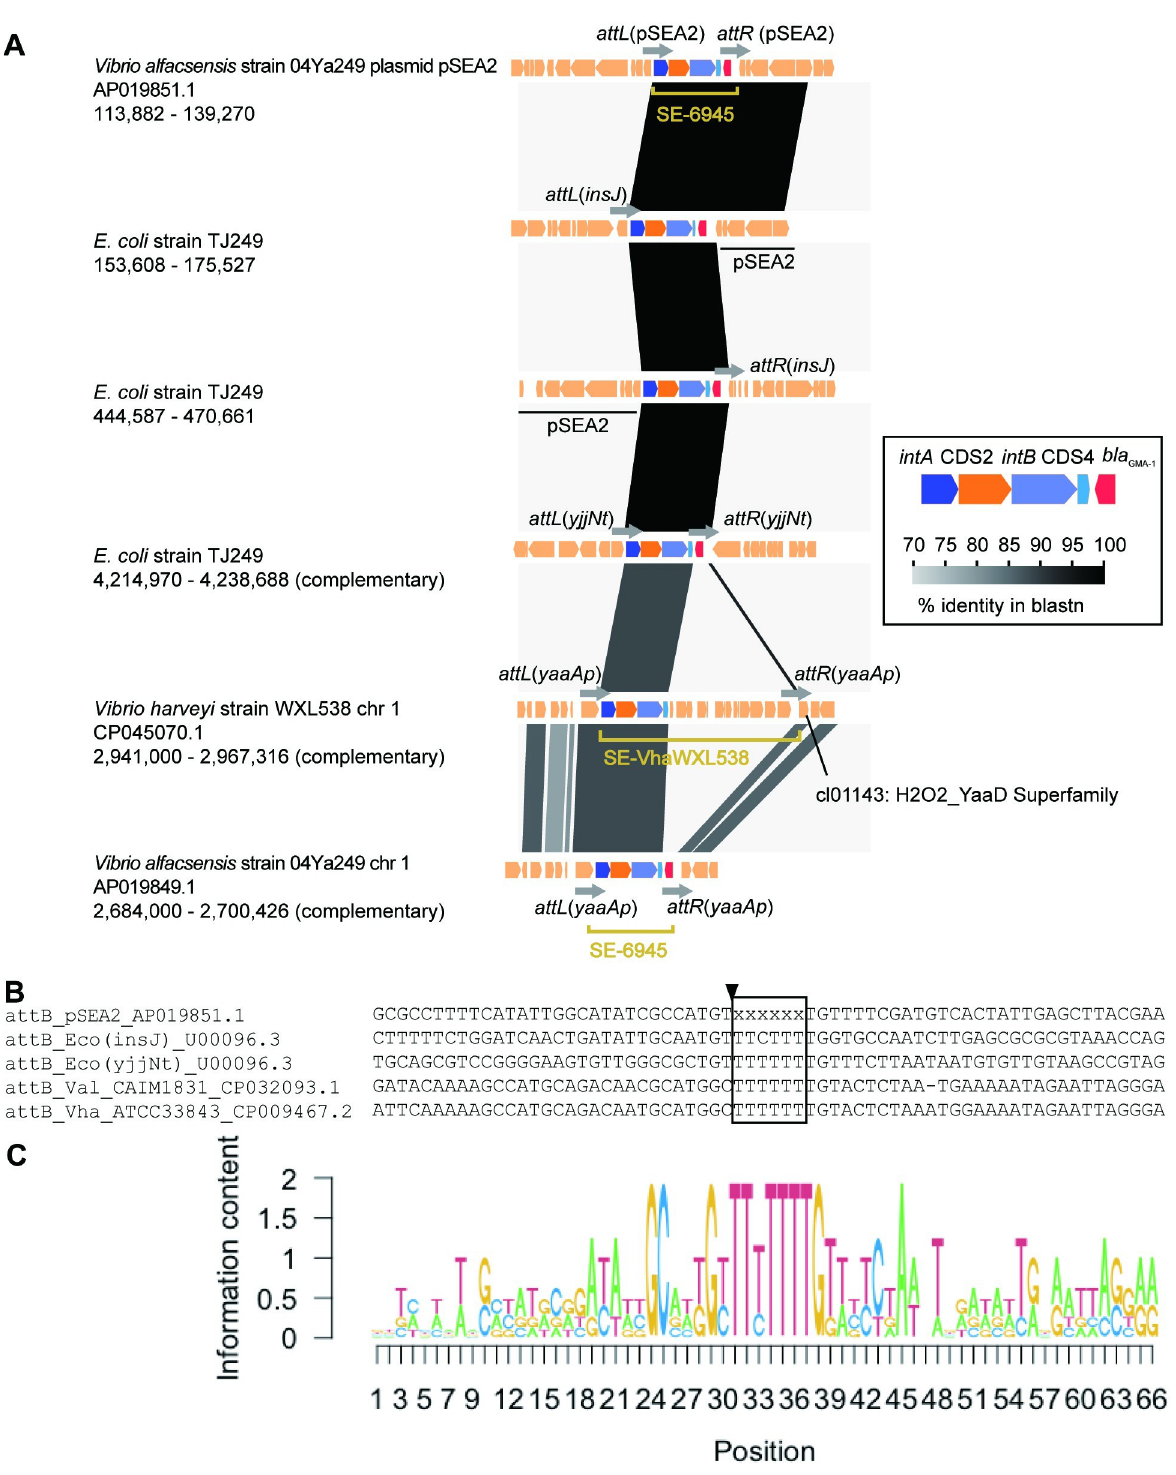
Fig 2. Locations of SE-6945 and its related elements. (A) Comparisons of genetic organization around SE insertion locations. GenBank accession numbers ( Vibrio strains only) and the coordinates of genomic segments compared are shown below the strain name. (B) Alignment of attB sequences. The sequences are retrieved from SE-free genomes. Since the SE-6945-free pSEA2 ancestor could not be found in the database, the bases in the putative crossover region could not be defined and are shown as x. Nicking is expected to take place next to the central box: position is shown by black arrowhead. (C) Sequence logo representation of conservation levels of attB